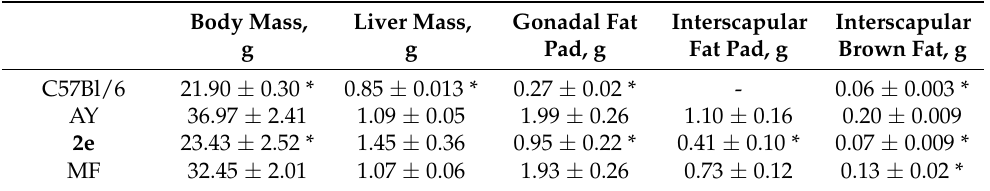
Table 5. Mass of AY mice’s livers and fat tissues at the end of the experiment. * p < 0.05 as compared to AY mice.